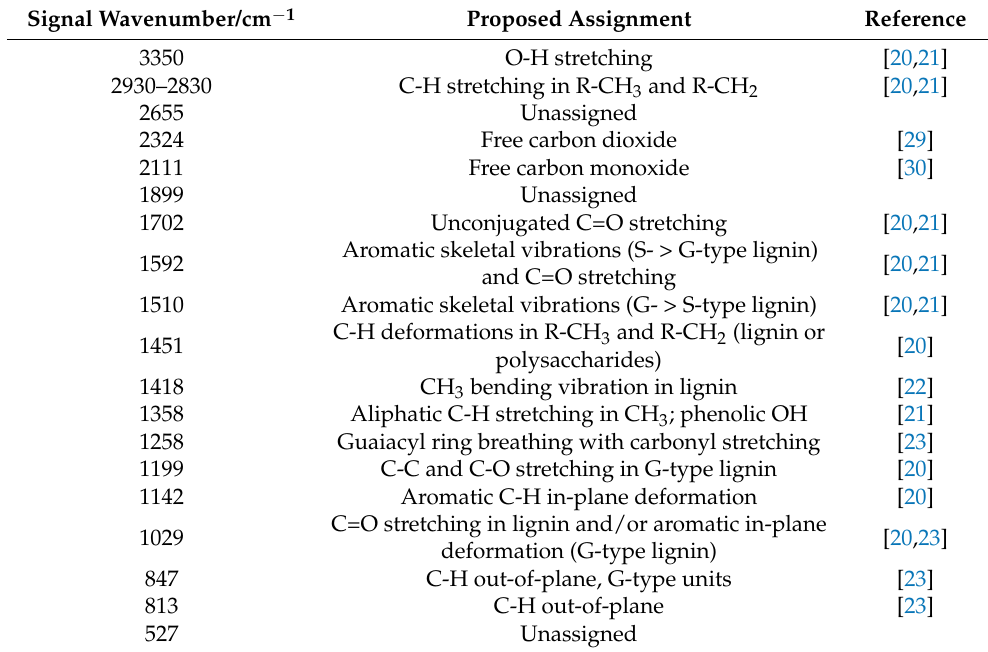
Table 2. Signal maximum wavenumber, proposed assignment of the signal, and literature source for the assignment of the coke and char of the four technical lignins (see in Figure 6). Signal Wavenumber/cm −